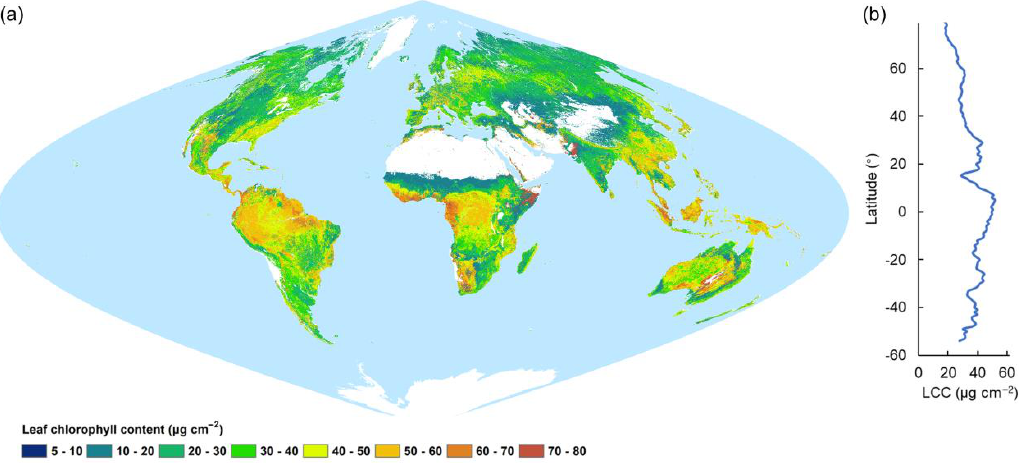
Figure 7. ( a ) The global annual mean map of GLCC in 2019 and ( b ) the mean values along latitudinal bands. bands.